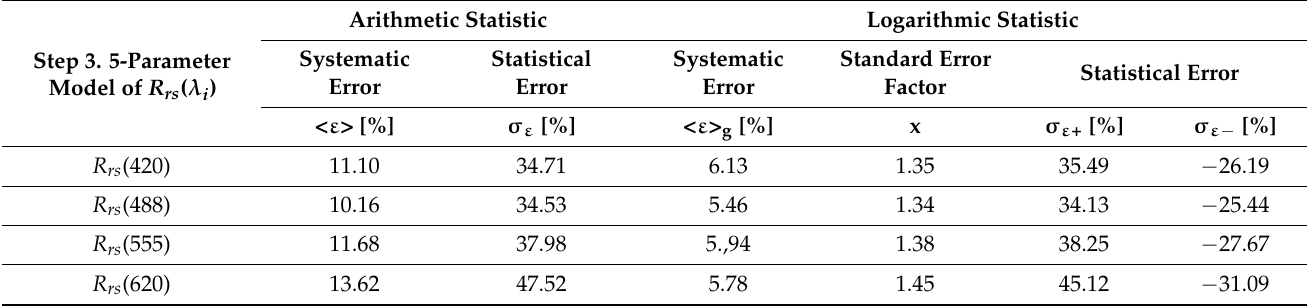
Table 4. The relative errors in the